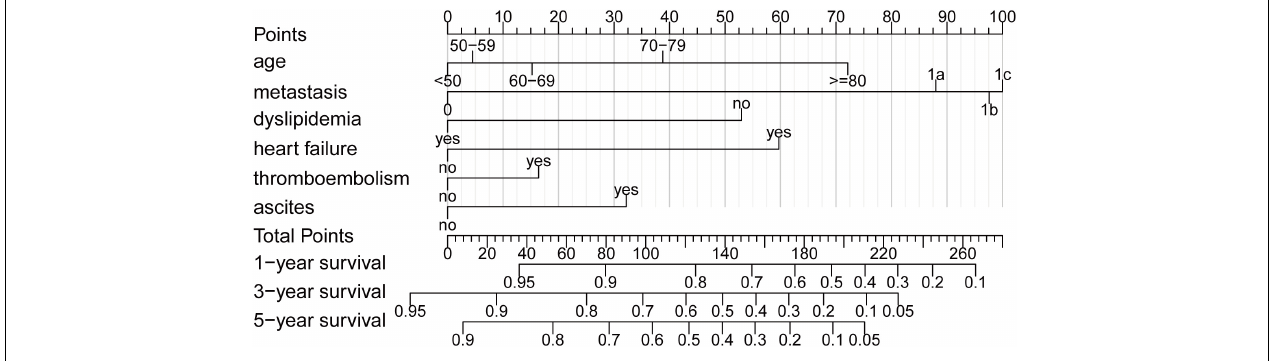
FIGURE 1 | Nomogram. Nomogram to predict the probability of 1-, 3-, and 5-year overall survival (OS) in patients with colorectal cancer (CRC). In addition, 1-, 3-, and 5-year OS could be obtained by adding up the points of each corresponding